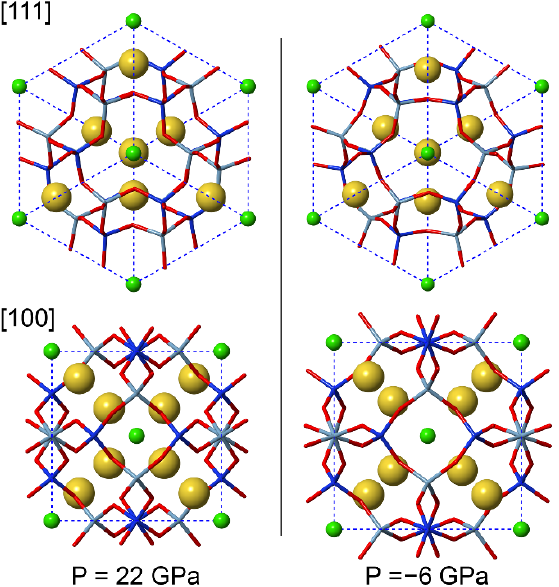
Figure 3. Sodalite framework at 22 GPa ( left ) and –6 GPa ( right ), as seen from the [111] and [100] directions. The wireframe structure is composed by Al (cyan), Si (blue) and O (red), whereas the Na and Cl atoms are shown as yellow and green spheres, respectively.